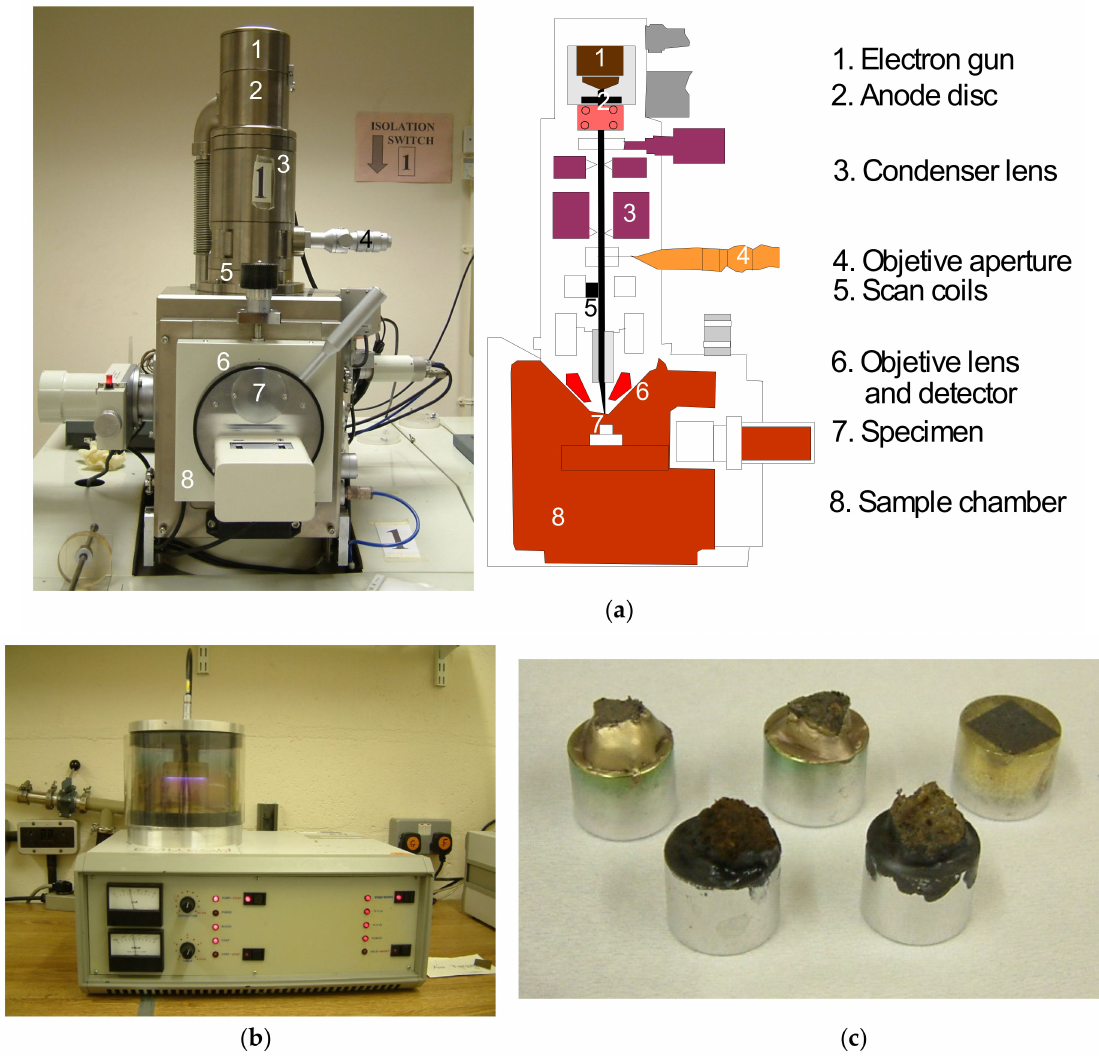
Figure 6. SEM and vacuum coating equipment: ( a ) SEM’s main components, ( b ) coating of samples with gold and ( c ) samples before and after